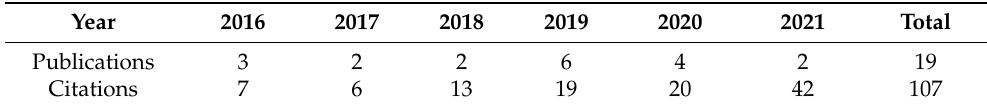
Table 8. Publication and citation counts based on the analysis pattern: TS = ((wave) AND energy security educ*). Source: Web of Science database.